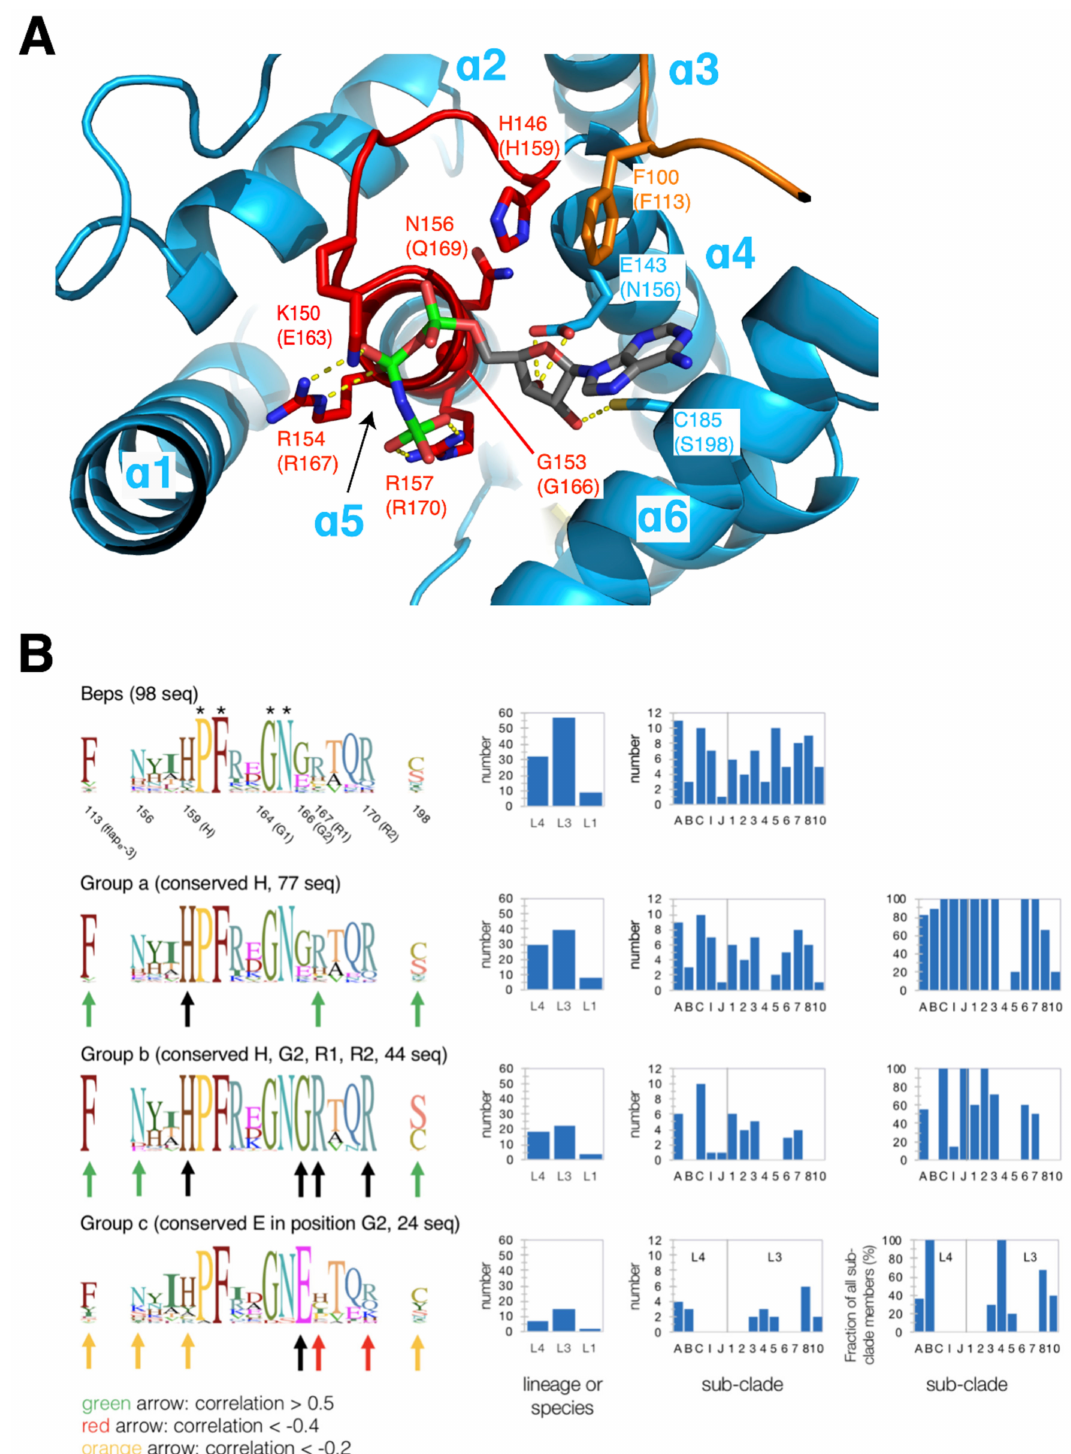
Figure 6. FIC substrate binding site: conservation and correlation. ( A ) Bhe_BepC structure with bound substrate analog AMPPNP (PDB ID: 4WGJ) corresponding to Figure 2C, but zoomed into the ligand binding pocket. The catalytic histidine H146 and residues interacting with the ligand are labeled (Bhe_BepA residue types and numbers in brackets). ( B ) Sequence logos encompassing the residues are shown in panel ( A ). The overall logo derived from all BepFic sequences as presented in Figure 3 is shown at the top followed by the logos of selected groups that comply to the criteria provided above the corresponding graph. Residues that show correlation or anti-correlation with the selected residue(s) (black arrows) are indicated by green (corr. > 0.5), orange (corr. < − 0.2), or red (corr. < − 0.4) arrows. A break-down of the group members into lineages and sub-clades (only for L3 and L4 members) is provided on the right